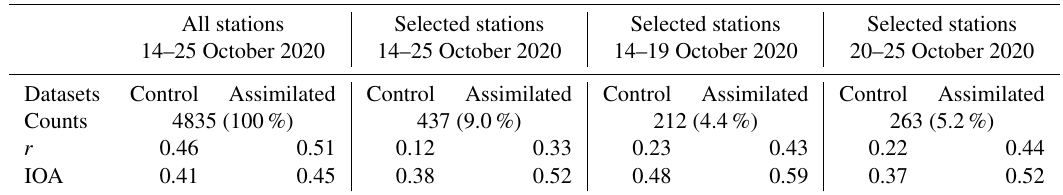
All stations Selected stations Selected stations Selected